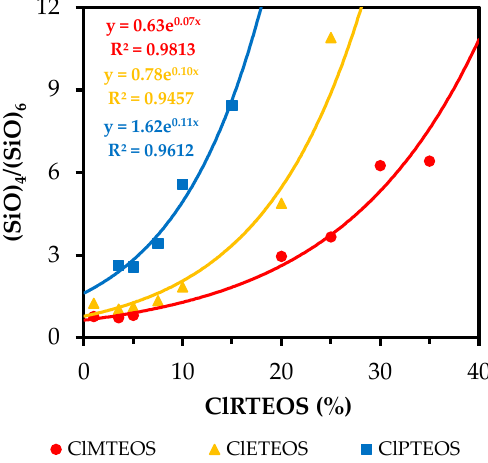
Figure 8. Variation in (SiO) 4 /(SiO) 6 as a function of the molar percentage of precursor in ClRTEOS:TEOS xerogels.